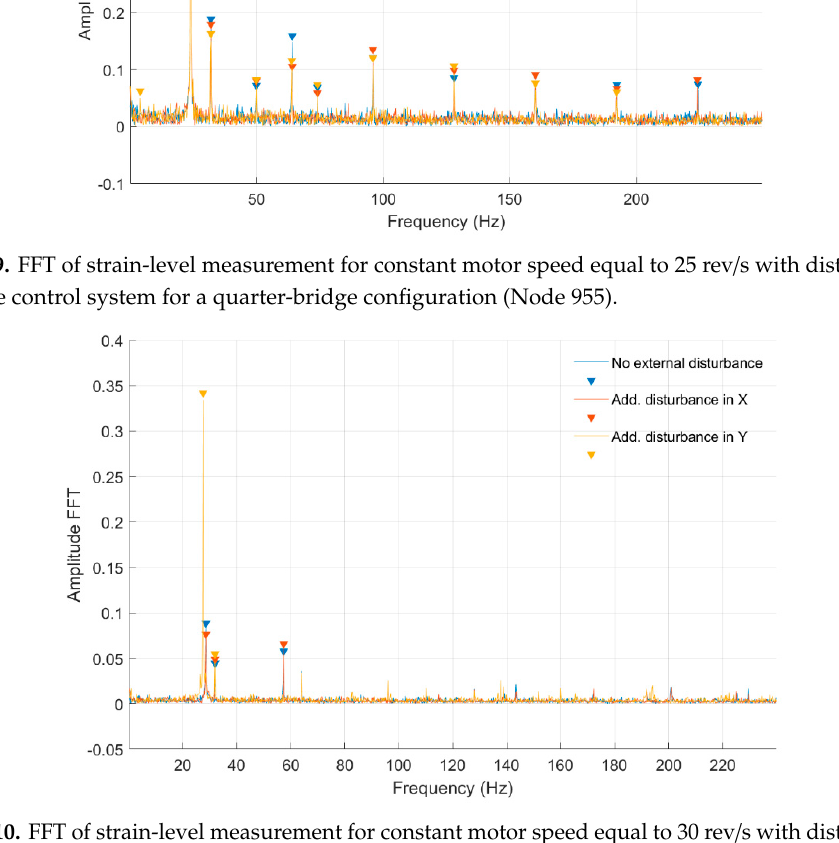
Figure 10. FFT of strain-level measurement for constant motor speed equal to 30 rev / s with disturbance from the control system for a full-bridge configuration (Node 954).